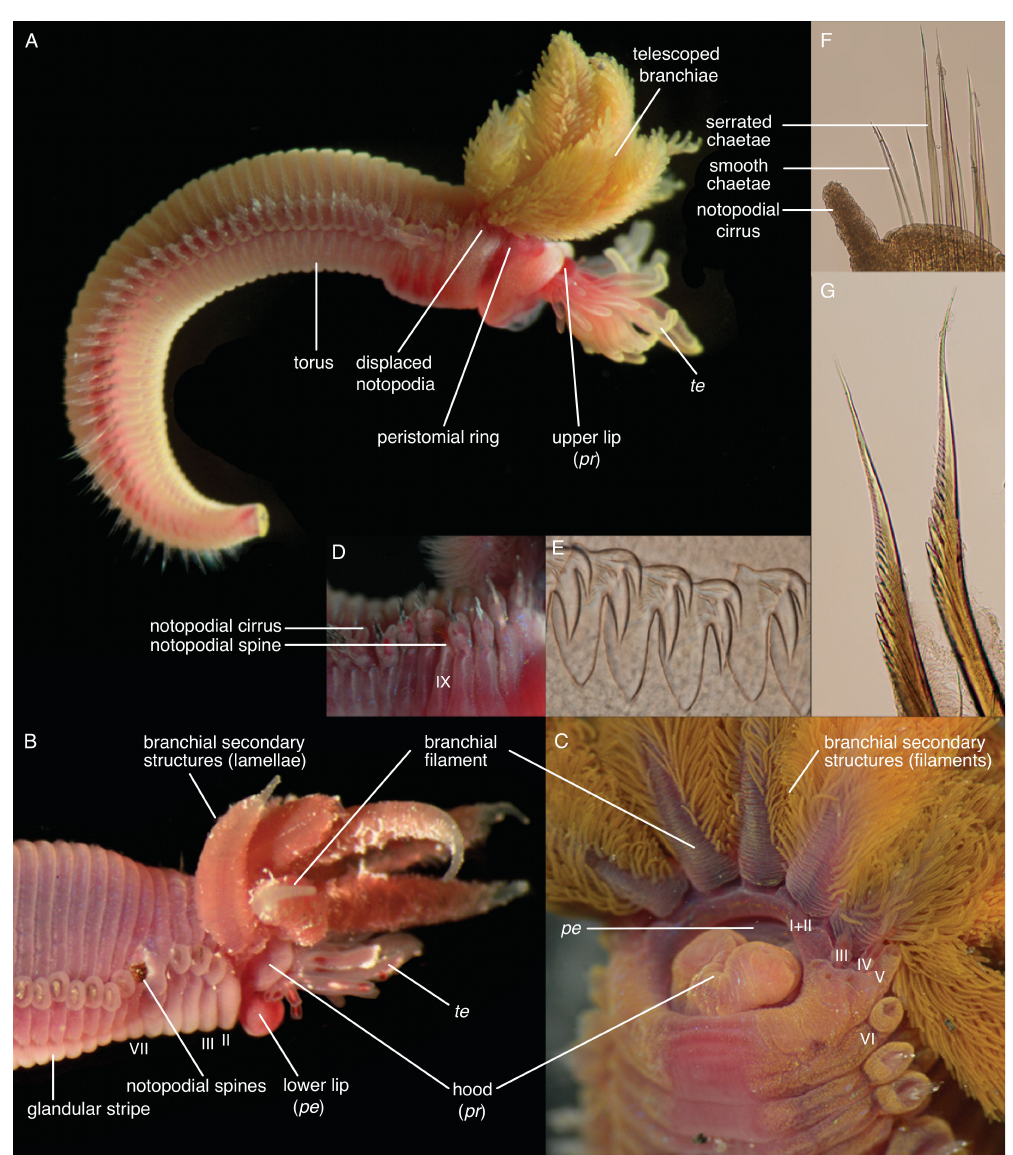
Figure A1. Morphology of Alvinellidae. ( A ) Paralvinella fijiensis , juvenile (SIO-BIC A8627). ( B ) Alvinella caudata (SIO-BIC A8618), anterior body with filamentous branchiae carrying lamellae as secondary structures. ( C ) Paralvinella fijiensis (SIO-BIC A8627), head with tentacles retracted into the mouth and the filamentous branchiae carrying smaller filaments as secondary structures. ( D ) Paralvinella fijiensis , closeup of notopodia with spines and cirri. ( E ) Paralvinella palmiformis (SIO-BIC A1104, 630 × ), uncini from posterior thorax with the characteristic single prominent tooth over the rostrum. ( F ) Paralvinella grasslei (SIO-BIC A1093, 200 × ), notopodial ramus with a notpodial cirrus and both smooth and serrated capillary chaetae. ( G ) Alvinella caudata (SIO-BIC A1092, 200 × ), capillary chaetae from mid thorax with serrated rims. Abbreviations: pe —peristomium, pr —prostomium, te —buccal palps or tentacles. Roman numerals designate segment